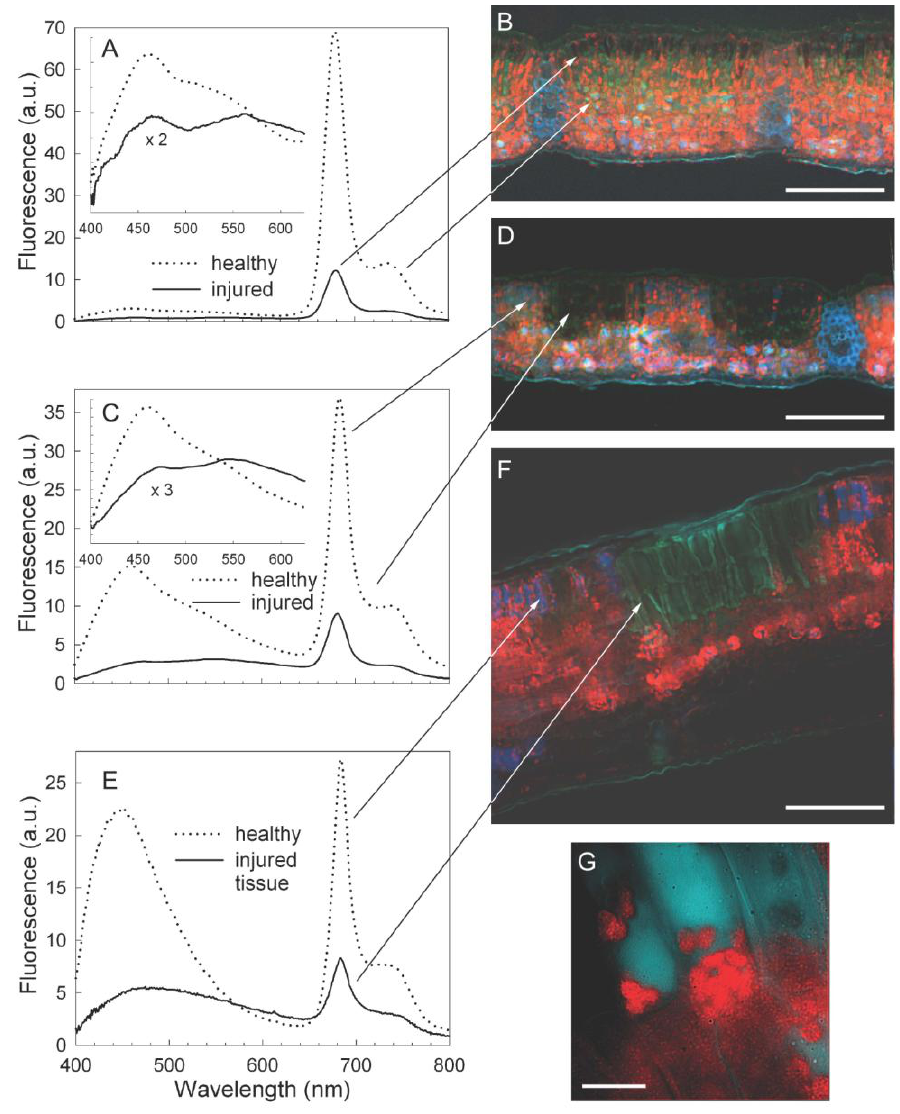
FIGURE 3. Multispectral autofluorescence microimaging and microspectrofluorometry of beech (A–D) and poplar (E–G) leaves injured by ozone. (A, B) Cross-section from a beech leaf with bronzing symptoms. (C– G) Cross-section from a beech (C, D) and a poplar (E–G) leaf with stippling symptoms. (A, C, E) UV- induced (365 nm) autofluorescence spectra recorded in the palisade parenchyma from healthy (dotted curves) and injured (solid curves) tissues; insets show the spectral shape in the blue-yellow range with the injured tissue fluorescence enhanced by a factor of 2 and 3 for beech with bronzing and stippling symptoms, respectively. (B, D, F) Fluorescence images obtained by RGB recombination of UV-excited (365 nm) monochrome images recorded at 470, 546, and 680 nm colored in blue, green, and red, respectively; bars = 100  m. (G) Fluorescence image of the healthy palisade in poplar obtained by RB recombination of UV- excited monochrome images recorded at 470 and 680 nm colored in blue and red, respectively; bar = 10 